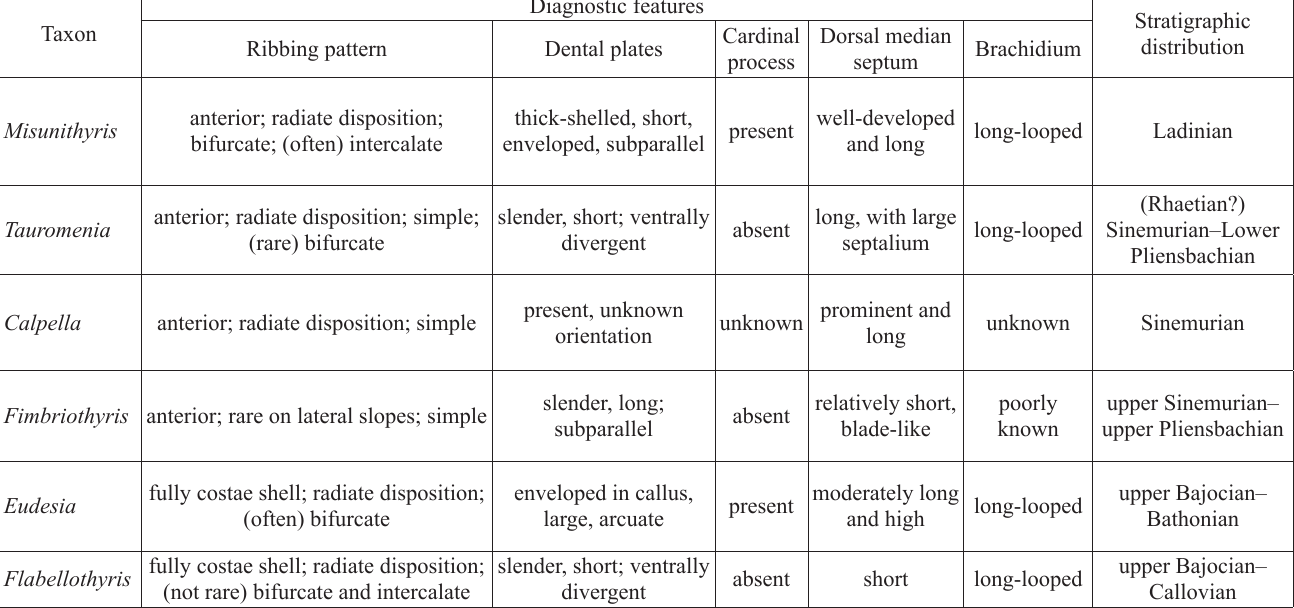
Table 2. Comparison of main attributes on Misunithyris gen. nov. with those of the Early–Middle Jurassic multicostate zeilleriid representatives. Diagnostic Taxon